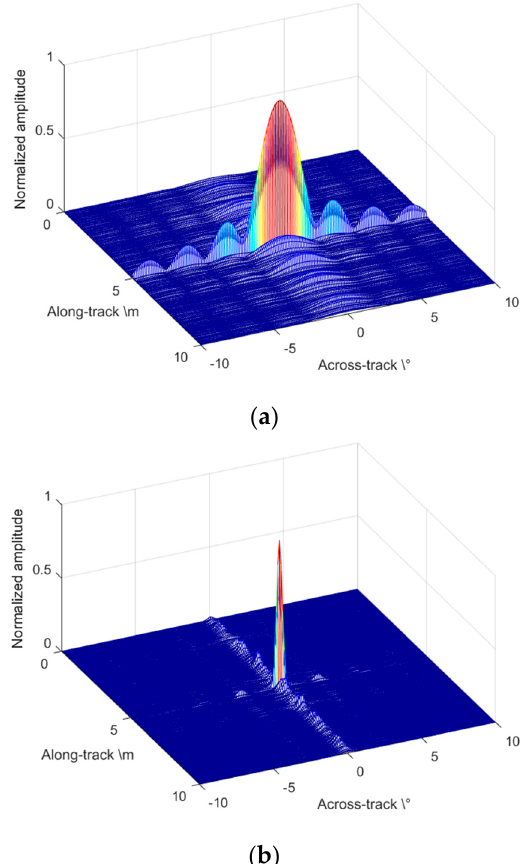
Figure 6. Imaging comparison of the single point target in the across-track direction: ( a ) slice of CBF; and ( b ) slice of accelerated deconvolved beamforming.